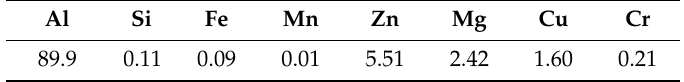
Table 1. Chemical composition of EN AW-7075 in wt. % supplied by NMD—New Materials Development GmbH (Heemsen, Germany). Measurements in accordance with EN 10204 3.1.